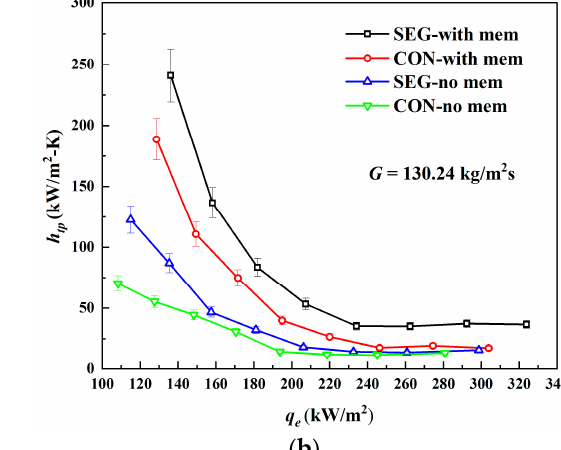
( b ) Figure 14. Two-phase heat transfer coefficients in the continuous and segmented heat sinks with and without the venting membrane: ( a ) G = 80.48 kg m − 2 s − 1 ; ( b ) G = 130.24 kg m − 2 s − 1 . The decrease in the heat transfer coefficient with the effective heat flux and the en- hancement by the vapor venting membrane can be explained based on the boiling mech-